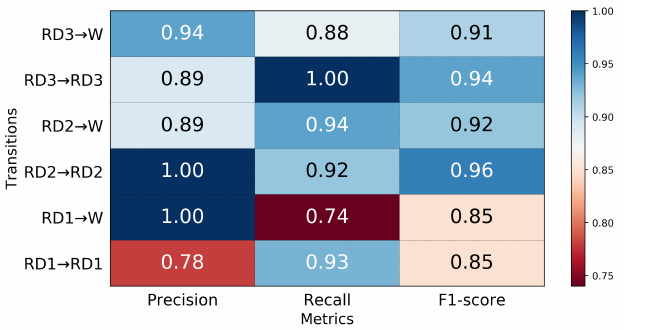
Figure 11. Confusion matrix of the average classification accuracy of predictions of transitions from ramp descent 250ms prior to TO.